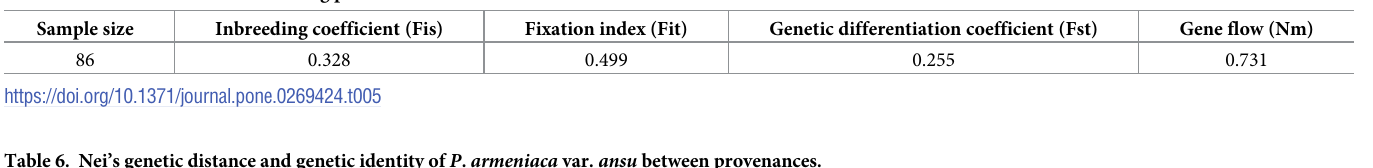
Table 6. Nei’s genetic distance and genetic identity of P . armeniaca var. ansu between provenances. Pengyang,